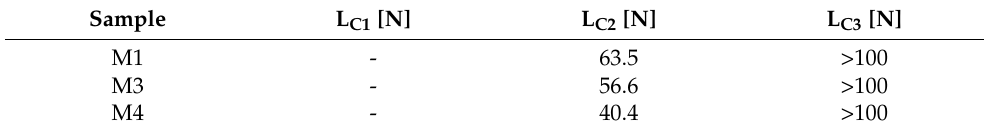
Figure 2. Scratch paths of the C-coatings. In the picture, just final parts of the paths are compared; the paths are incommensurable in this picture.